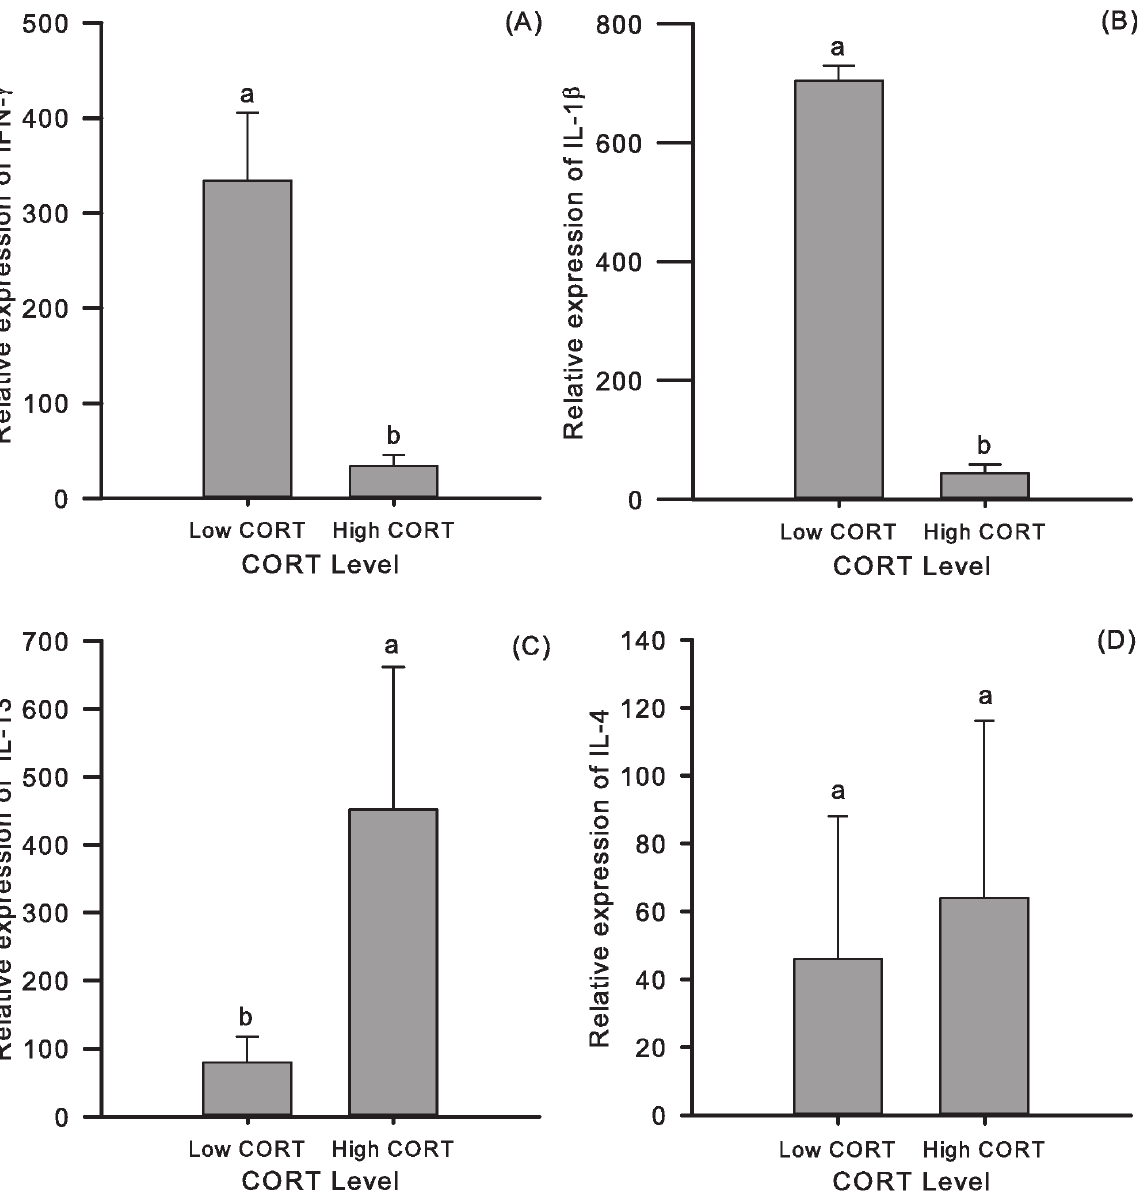
Fig 4. Analysis of molecular mediators in divergent Low and High CORT groups. Effect of the aggrupation dependent on the basal levels of CORT on the expression of two pro-inflammatory (IFN- γ and IL-1 β , panels A and B) and two anti-inflammatory mediators (IL-13 and 4, panels C and D). Data are adjusted means (number inside bars) ± SE. Number of birds per group = 10. Different letters indicate significant ( p < 0.05) differences between groups. The relative expression of each target gene was calculated using the formula: Gene Level = 2 -(Target Gene Ct – β -Actin Ct) . The value obtained was then multiplied by 1x10 8 in order to fit the scale of the